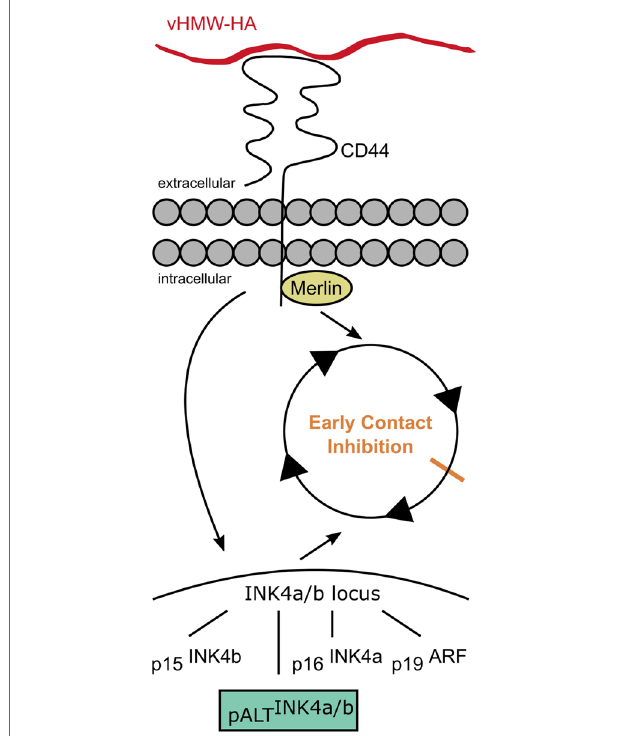
FiGURe 3 | Early contact inhibition. The uniquely mutated hyaluronan synthase 2 of the naked mole rat produces very high molecular weight HA (vHMW-HA) which triggers a signaling cascade via the CD44 receptor activating the INK4a/b locus and inducing the intracellular interaction of CD44 with merlin. The activated INK4a/b locus encodes for the tumor suppressors p15, p16, and p19 that arrest the cell cycle. In addition, naked mole rats possess a unique fourth hybrid form, pALT, which stops the cell cycle more efficiently. Interactions of CD44 with merlin contribute to the cell–cell contact-induced growth